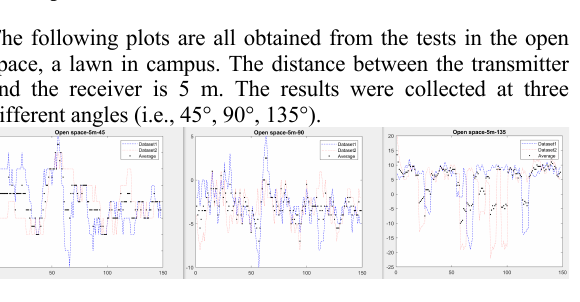
Figure 10 . Results of the tests in the open site.